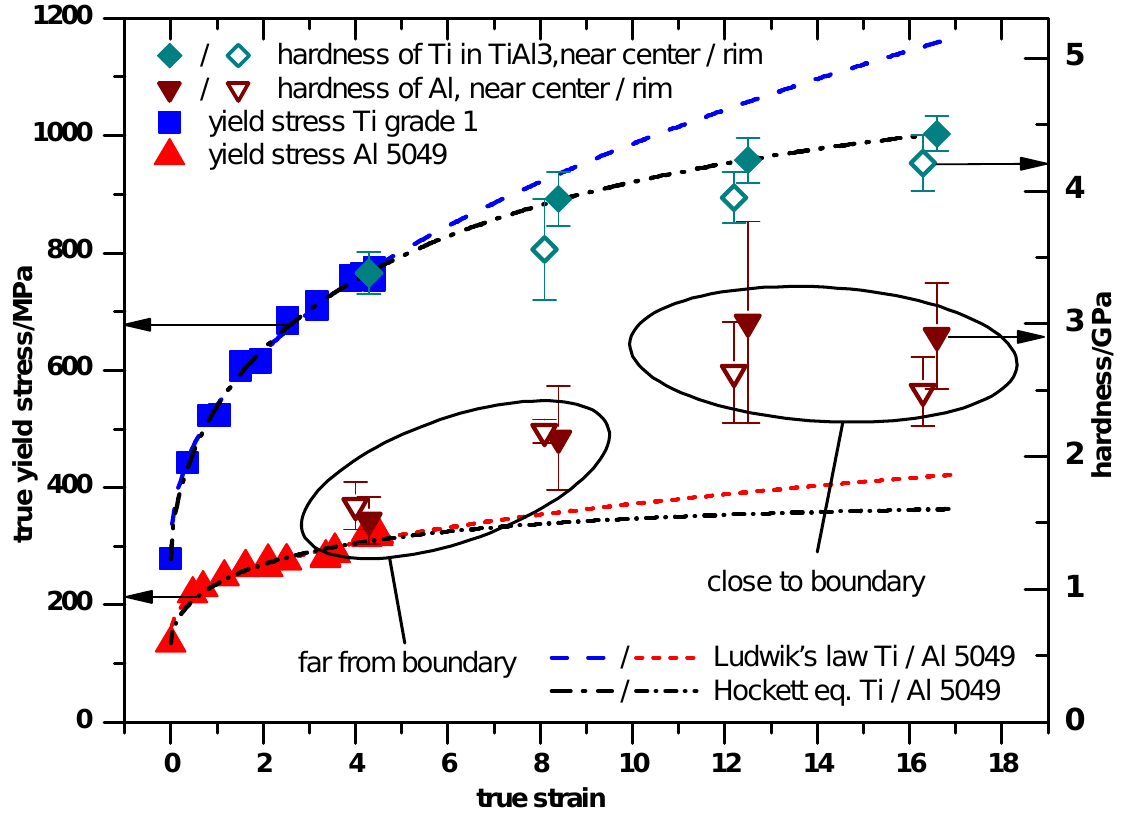
Figure 7. A combination of Figure 1 and Figure 3a. Data points with error bars belong to the right axis, providing good agreement for Hockett’s equation and TiAl3 titanium